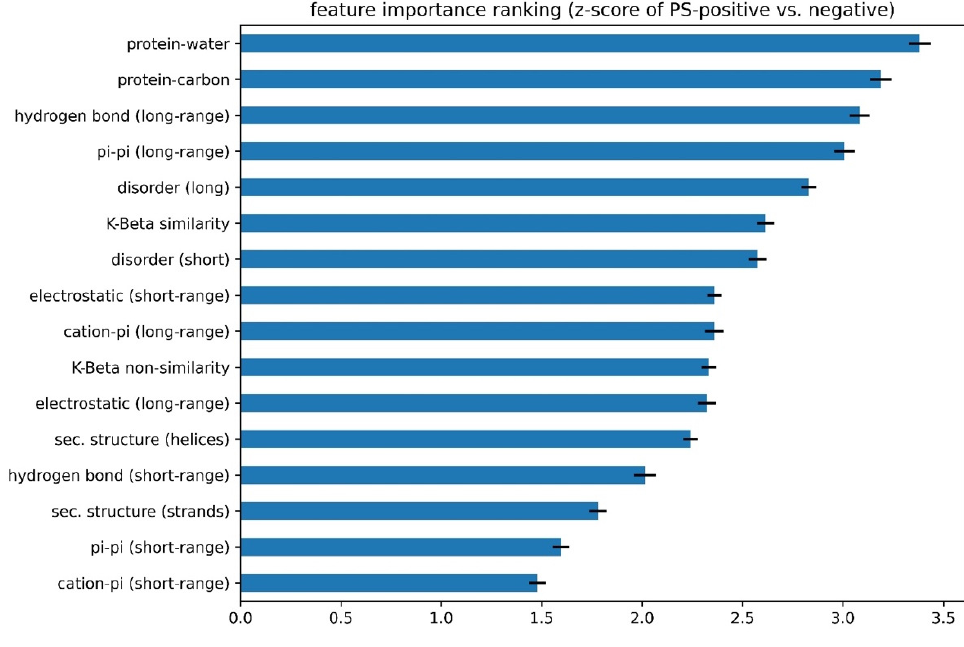
Figure 5. Ranking of the importance of features to discrimination in the developing phase-separation predictor between PS-positive and PS-negative sequences. The z-score of PS-positive sequences’ individual feature values against the mean PS-negative sequences’ values is shown.